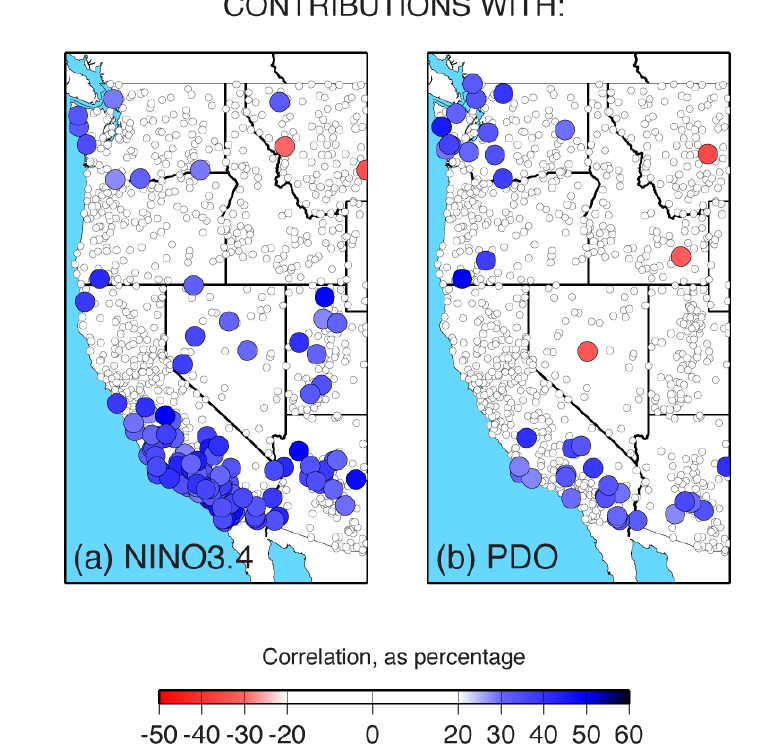
Figure 12. Correlations between PE contributions to water-year precipitation totals and concurrent water-year averages of (a) the Nino3.4 [31] sea-surface temperature (SST) index of the tropical ENSO climate mode, averaging SSTs in the region 5° N–5° S, 120° W–170° W, and (b) the Pacific Decadal Oscillation SST-based index [32]; colored dots indicate cooperative weather stations where the correlations are significantly different from zero at 95% confidence level and small gray dots are stations where the relations are not significant at this